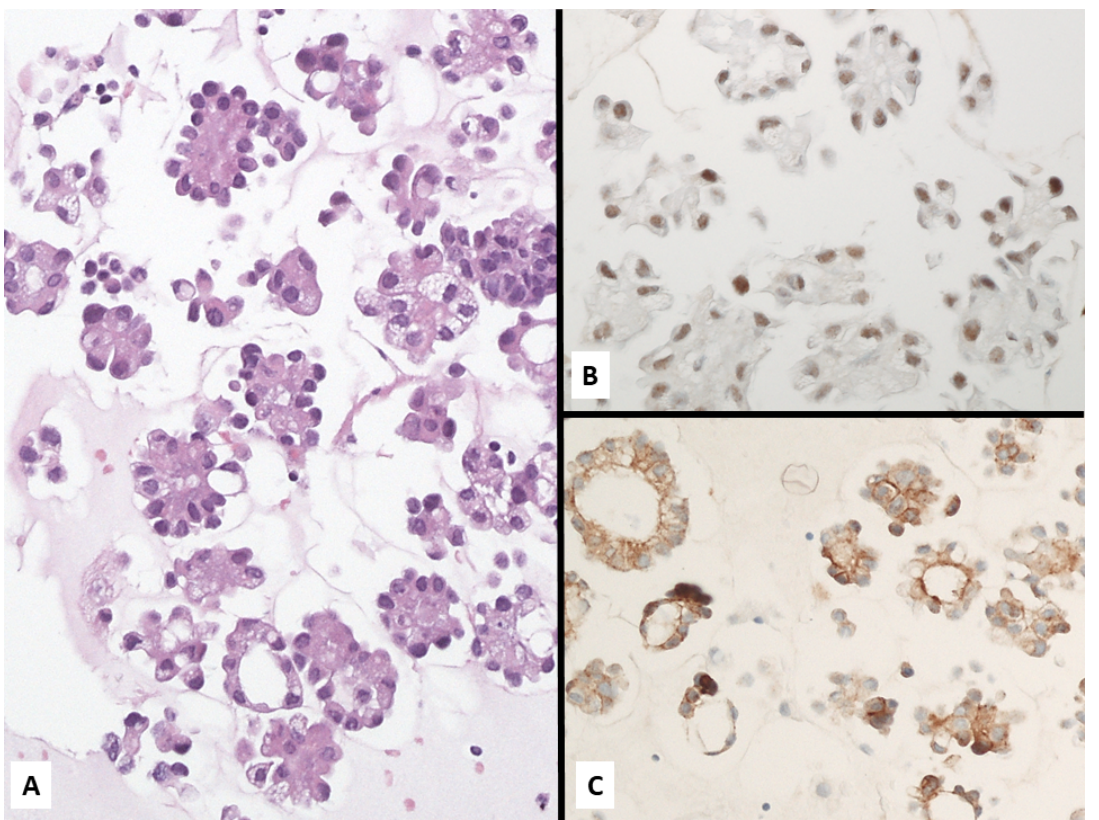
Figure 15. Metastatic breast carcinoma showing malignant epithelioid cells arranged in tiny nests ( A ) coordinately expressing BAP1 ( B ) and claudin-4 ( C ).